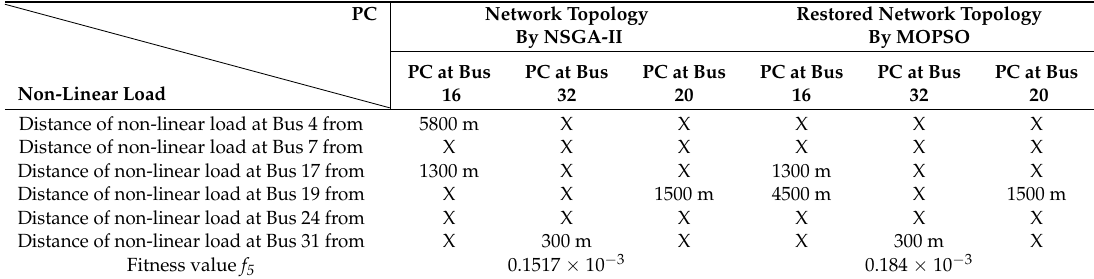
Table 8. The total distance of non-linear loads from the priority buses for Non-Dominated Sorting Genetic Algorithm-II (NSGA-II) and Multi-Objective Particle Swarm Optimization (MOPSO).